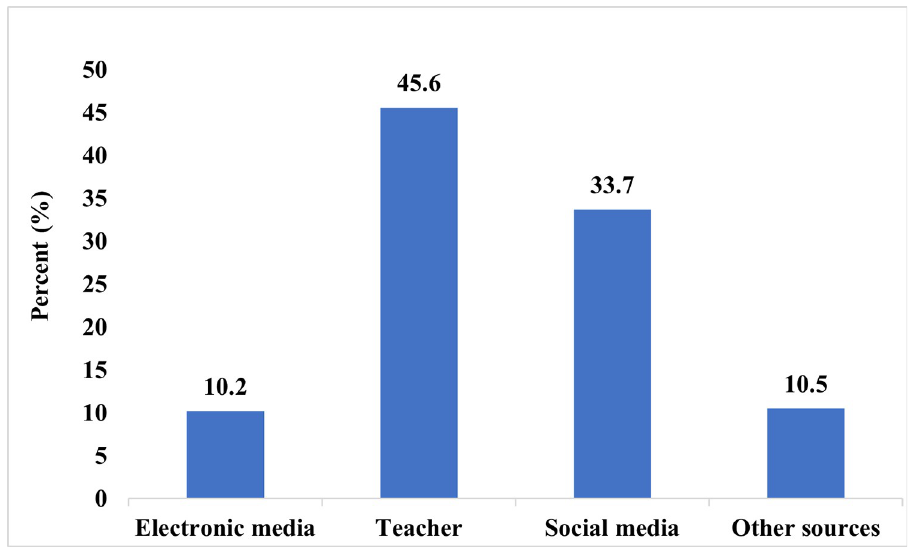
Fig 1. Sources of information on Ghana’s abortion law.